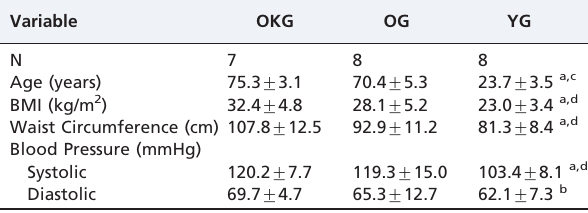
Table 1 - Subject characteristics at